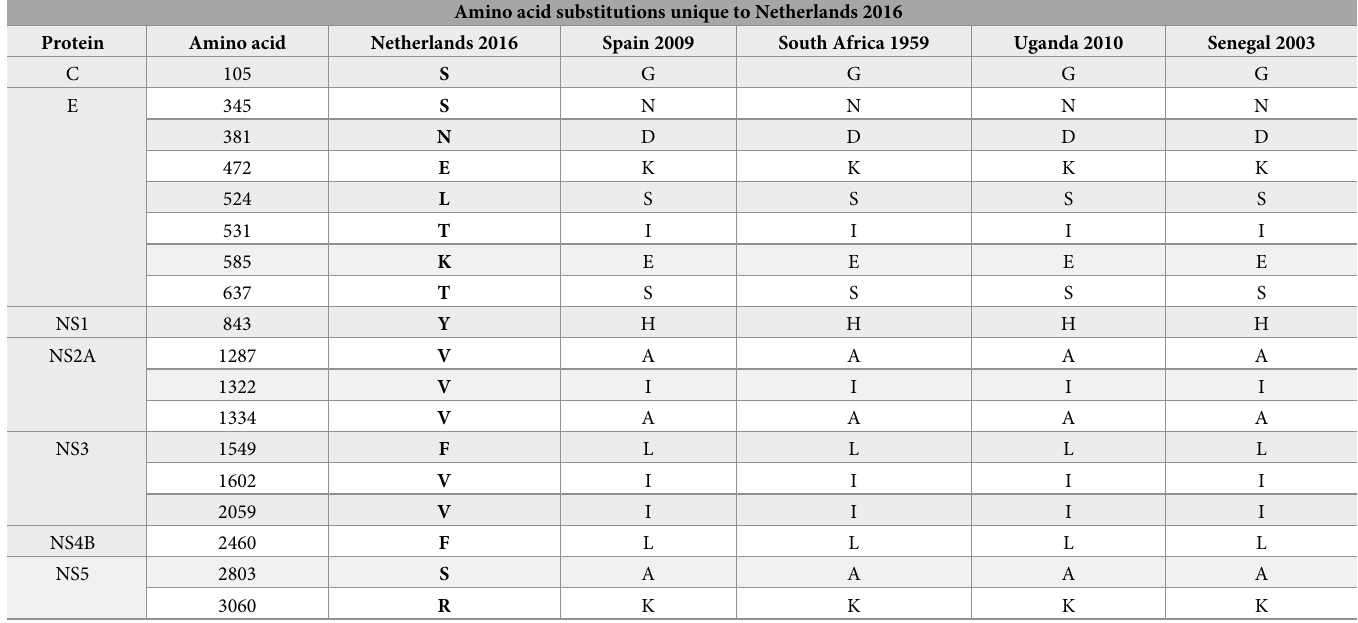
Table 2. Amino acid differences between Netherlands 2016 and other USUV